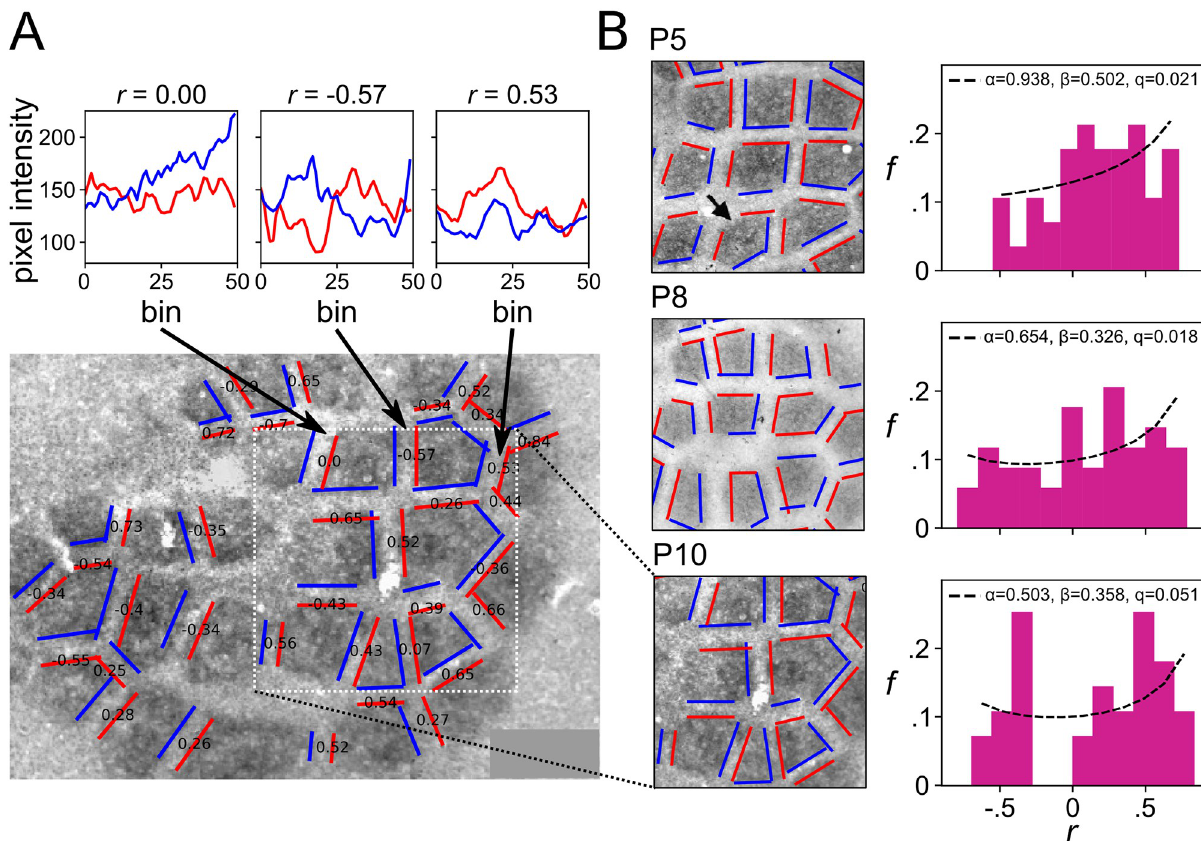
Fig 6. Emergence of correlated patterns in adjacent domains of the developing neocortex. We analysed images of immunohistochemical stains for serotonin transporter (5-HTT) expression on the surface of the rat barrel cortex, obtained at postnatal days 5 (P5), 8 (P8), and 10 (P10). This stain reveals the shapes of the barrel columns, each corresponding to a whisker on the animal’s snout, as large dark polygonal patches forming a Voronoi tessellation. From P8, sub-barrel structures become apparent and by P10 they clearly identify several regions of high synaptic density within many barrels. Panel A shows the details of the analysis method for the P10 image. Overlaid pairs of parallel red and blue lines show the extents along which image intensity was sampled for each pairwise comparison. Each line marks a vertex of the barrel boundary, and samples were constructed by averaging the grayscale intensity of pixels in one of 50 regularly spaced rectangular bins extending a short distance in from the line towards the corresponding barrel center. The correlation coefficient for each pair of samples is shown in black text, and the plots above show sampled data used for three example pairwise comparisons. Distributions of correlation coefficients obtained from pairs of edges from adjacent barrels are shown for each postnatal day in B , showing a clear progression from a unimodal shape at P5 to a bimodal shape at P10, and supporting the hypothesis that pattern formation within the barrels occurs postnatally and is constrained by the barrel boundary shapes. Original images from